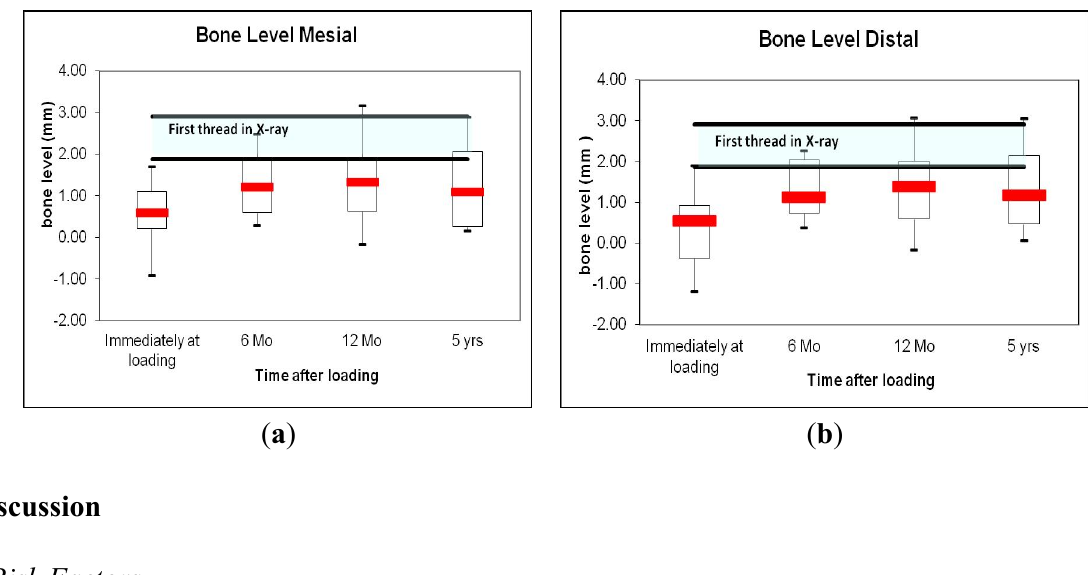
Figure 3. Radiological Parameters: Mesial ( a ) and distal ( b ) bone levels as determined by x-ray at baseline (immediately after loading), 6 months, 12 months and 5 years